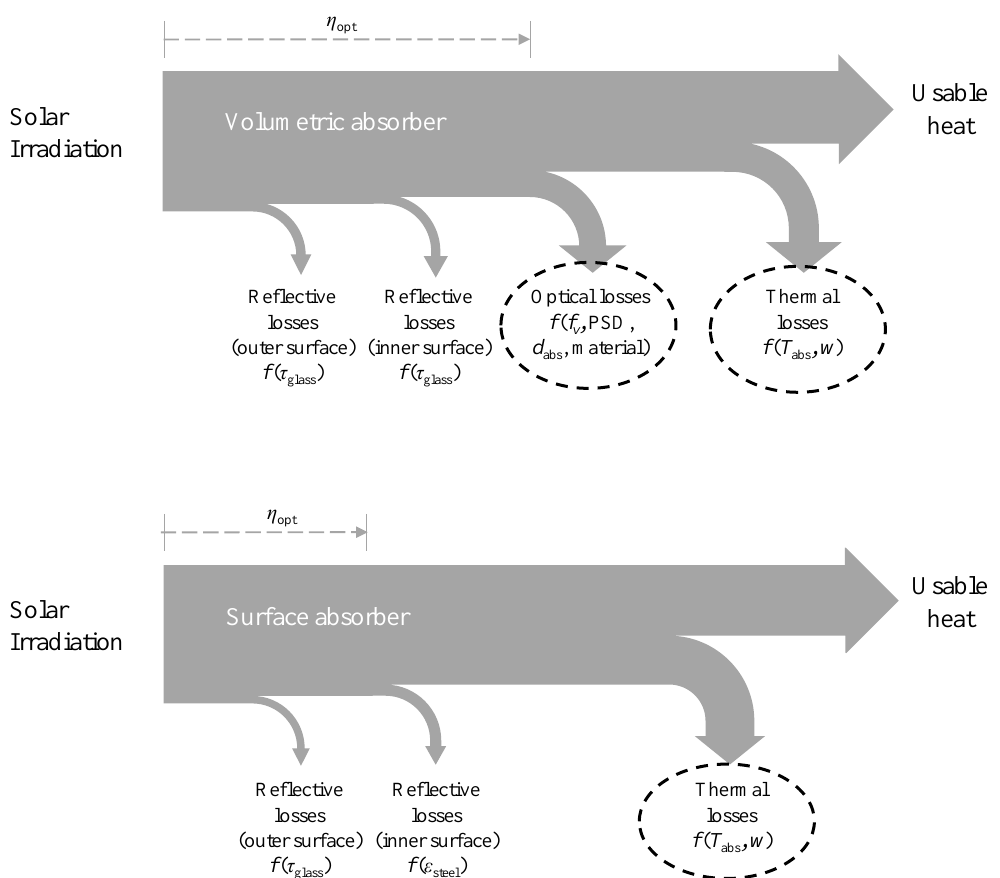
Figure 8. The energy flow chart shows the main difference between the surface absorber and the volumetric absorber